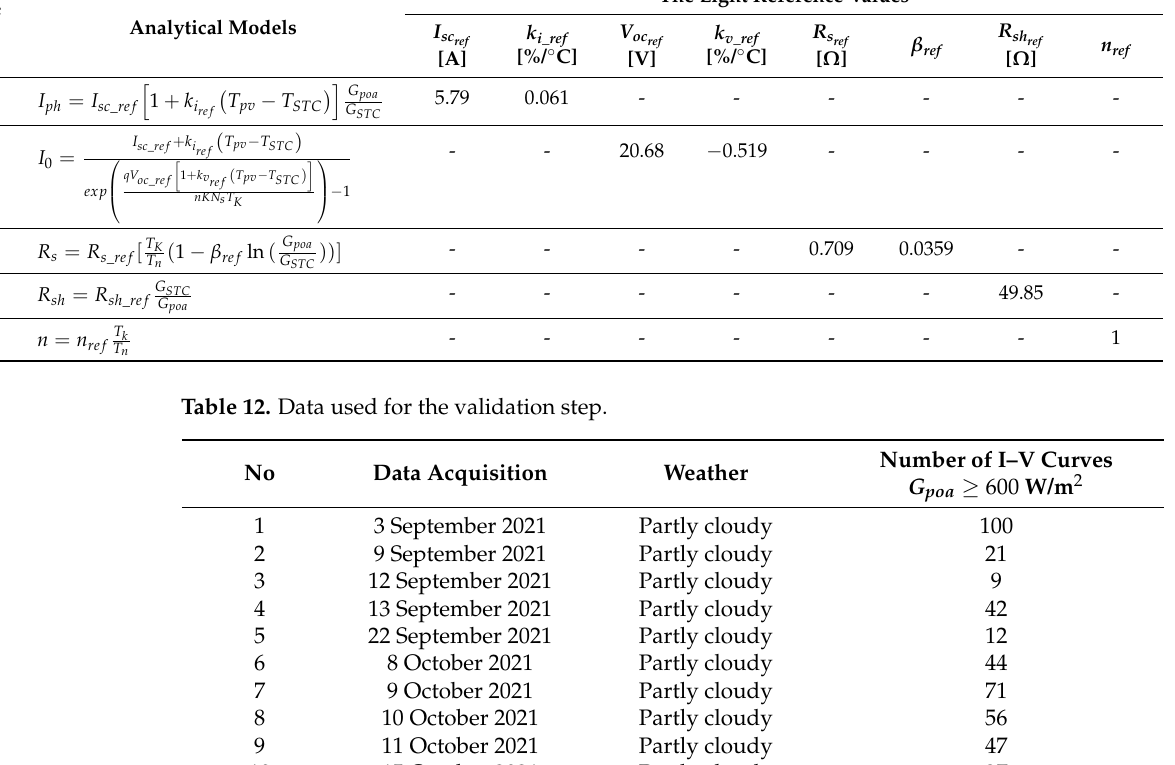
Figure 18 . Evolution of the diode ideality factor ( 𝑛 ). Figure 18. Evolution of the diode ideality factor ( n ).